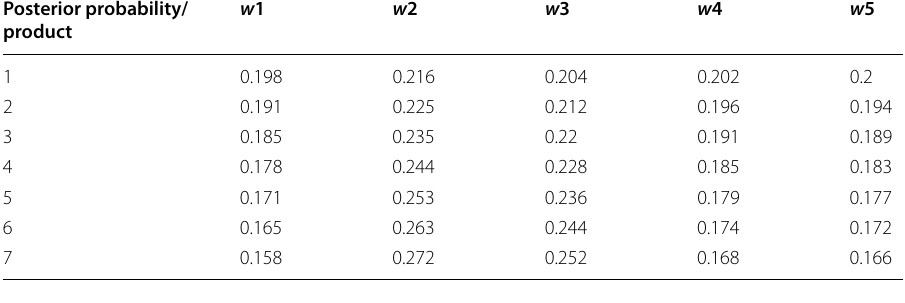
Table 2 The posterior probability of the demand mode of the first 5 products Posterior probability/ product